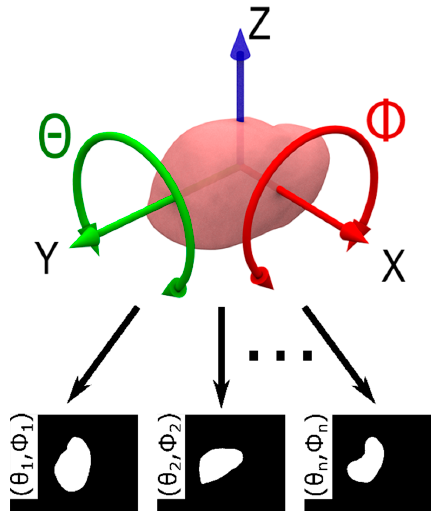
Figure 4. Rotation angles of liver phantom used in the MARVIS system, where Φ and θ are the rotations about the X and Y axes, respectively.